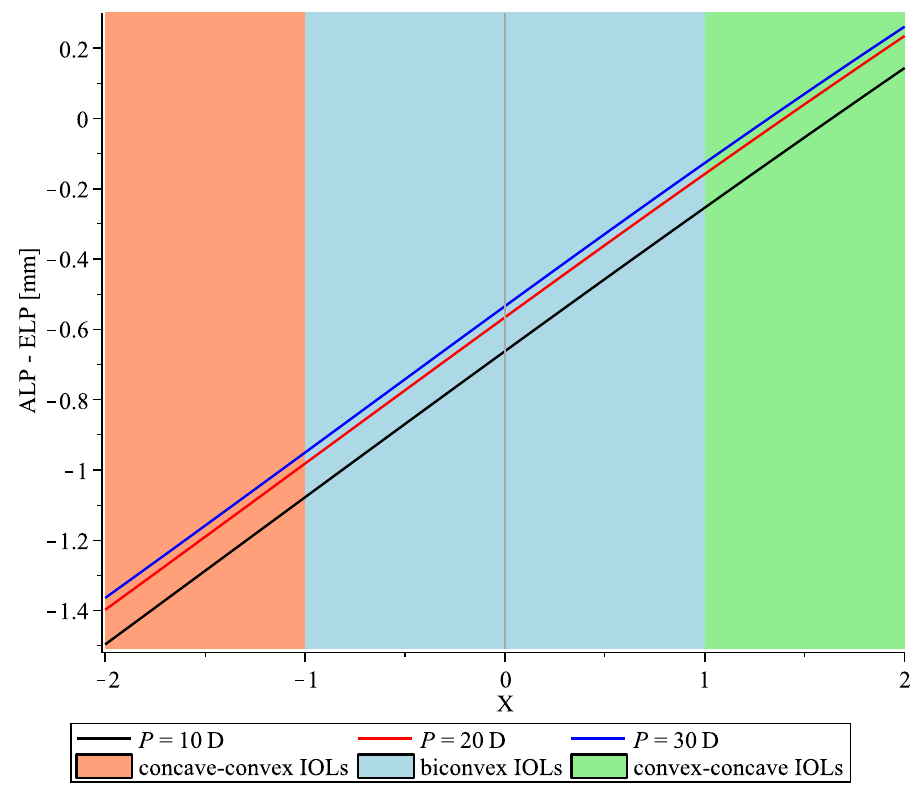
Fig 3. The difference between the anterior intraocular lens (IOL) vertex and the effective lens position of the thin lens equivalent as a function of the shape-factor for IOLs with optical power P = 10 D, 20 D, 30 D.